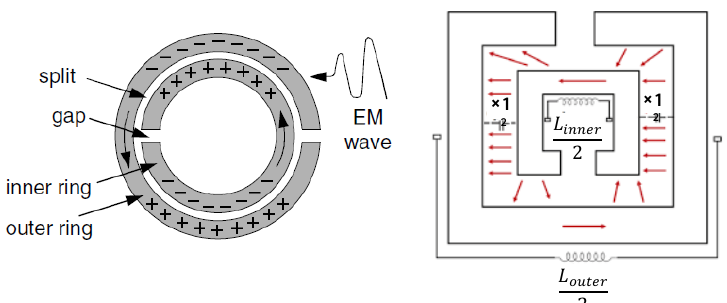
Figure 8. Electric current flow on split-ring resonators (SRRs).